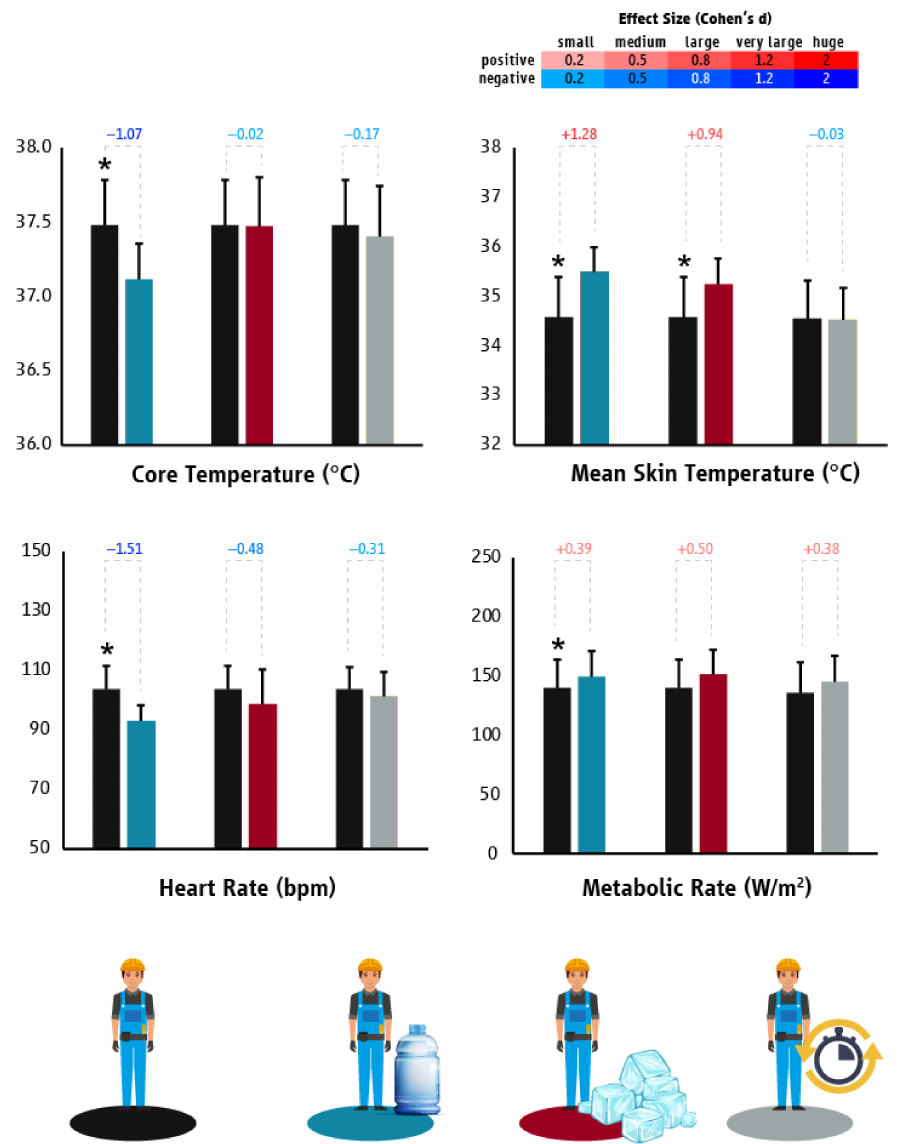
Figure 8. Differences (mean ± SD) in core temperature, mean skin temperature, heart rate, and metabolic rate/work intensity between “business as usual” and the tested heat mitigation strategies in the construction sector of Spain. Black, light blue, red, and grey colors represent “business as usual”, hydration, ice slurry, and planned breaks scenarios, respectively. Asterisks indicate statistically significant differences between “business as usual” and the tested heat mitigation strategies. Cohen’s d effect sizes show the magnitude (small: 0.2; medium: 0.5; large: 0.8; very large: 1.2; huge: 2.0) and direction (positive: shades of red; negative: shades of blue) of the differences between “business as usual” and the tested heat mitigation